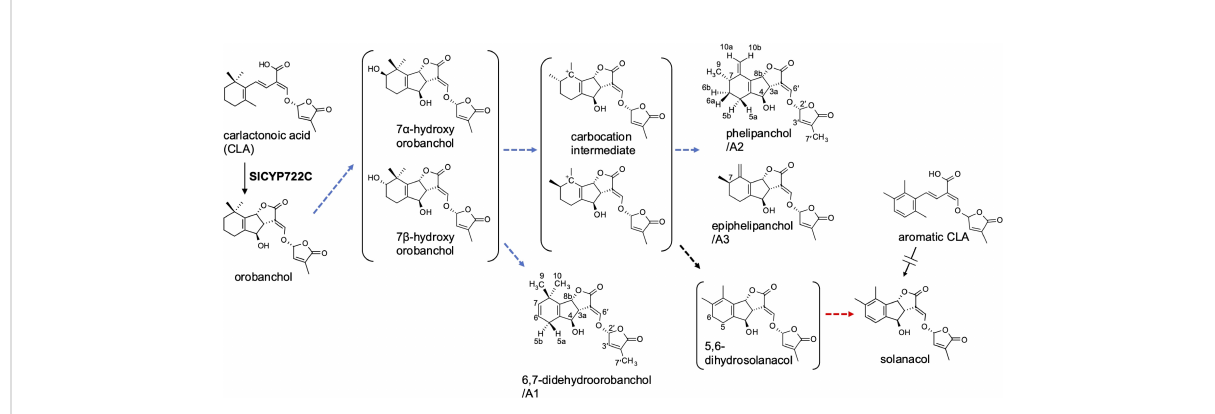
FIGURE 1 The proposed SL biosynthetic pathway from CLA to solanacol in tomato incorporating the novel SLs identi fi ed in this study. Blue and red dashed arrows indicate putative steps involving SlCYP712G1 and novel biosynthetic enzyme,